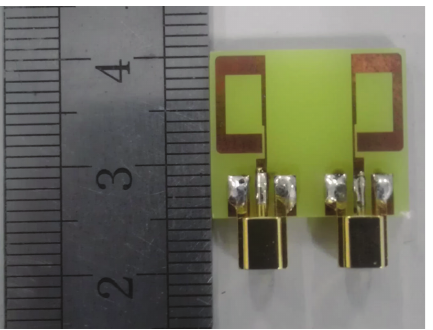
Figure 8: Photograph of the fabricated MIMO antenna system.